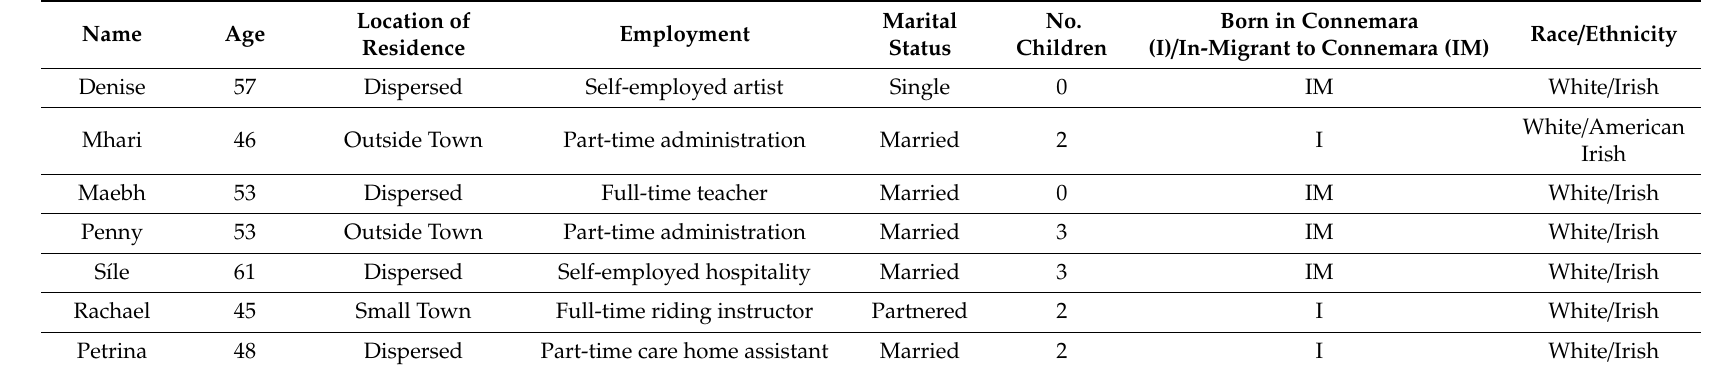
Table A1. Demographic table Ireland study.